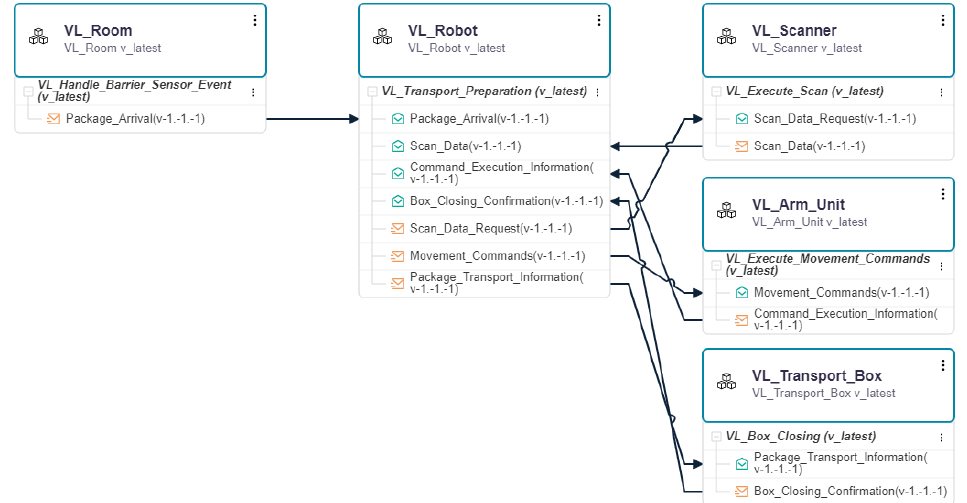
Figure 5. Vaccine logistics illustration case - Interaction between different components during transport preparation.